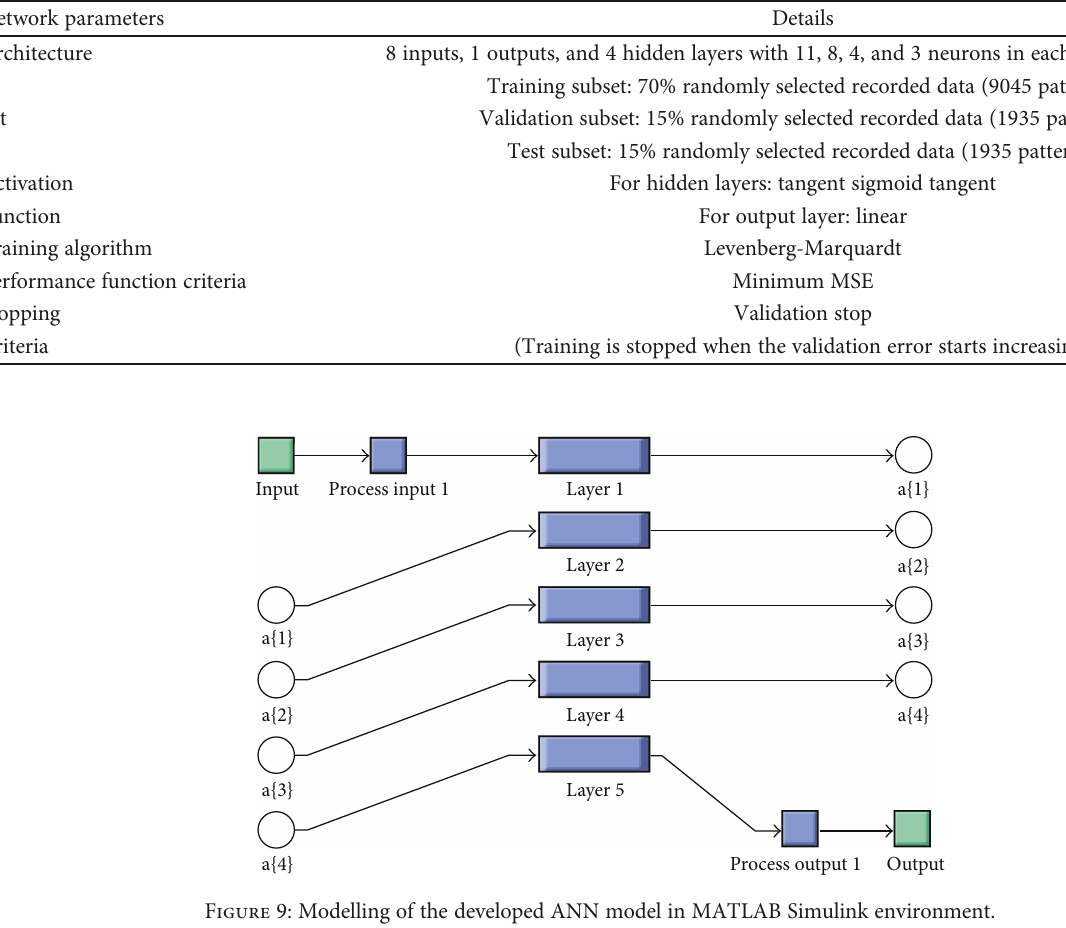
Table 14: Details of the neural model.